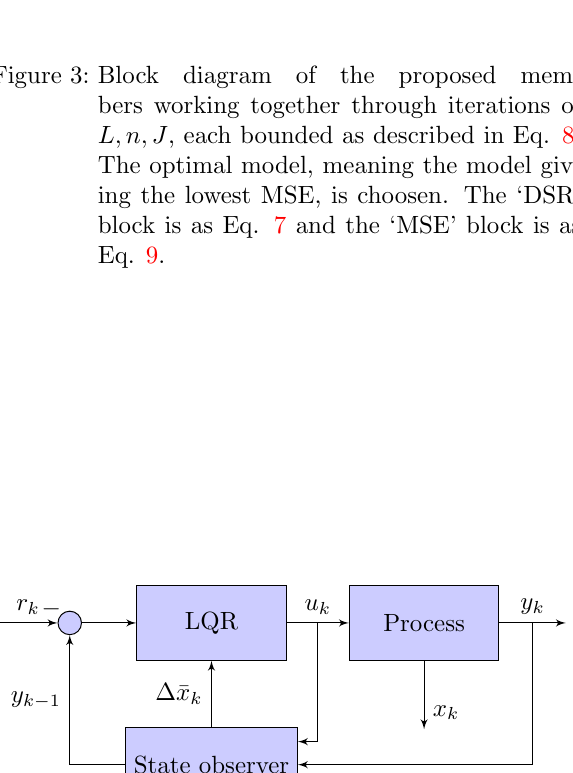
Figure 2: Block diagram of the proposed members working together through iterations of k , bounded as 1 ≤ k ≤ N , to produce the input and output data, u k and y k , which is to be organized in matrices, Y and U as in Eq. 3.